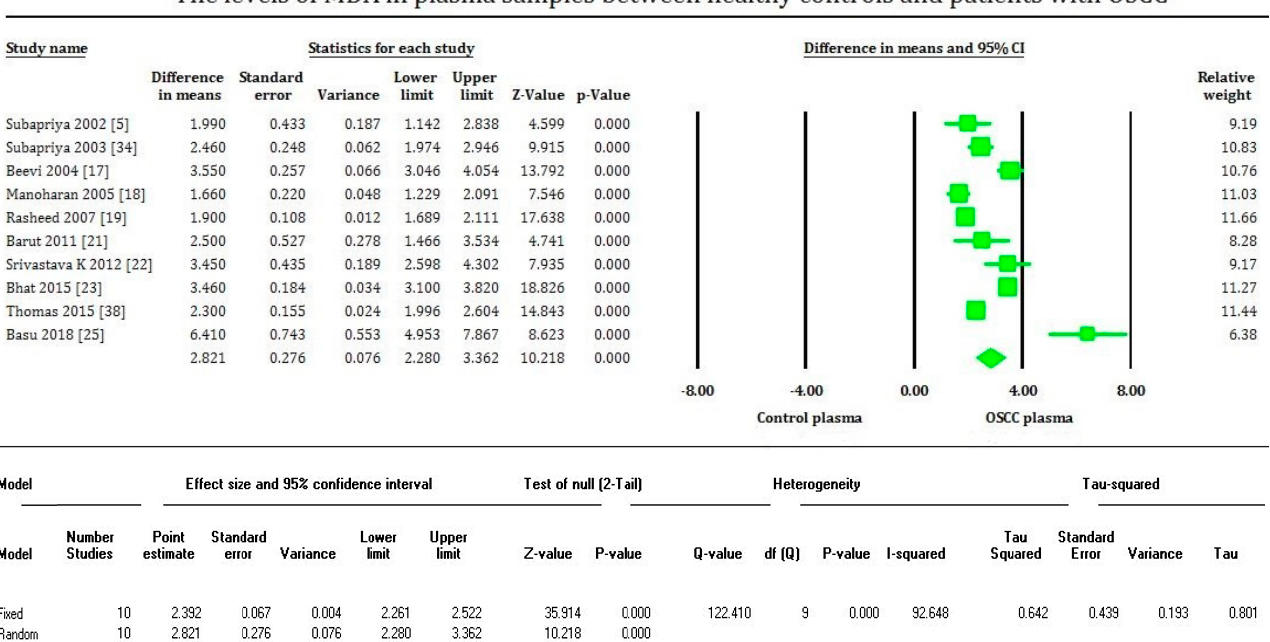
Figure 2. Forest plot shows mean difference estimates with 95% confidence intervals representing differences in plasma levels of MDA between the oral squamous cell carcinoma group and healthy controls.